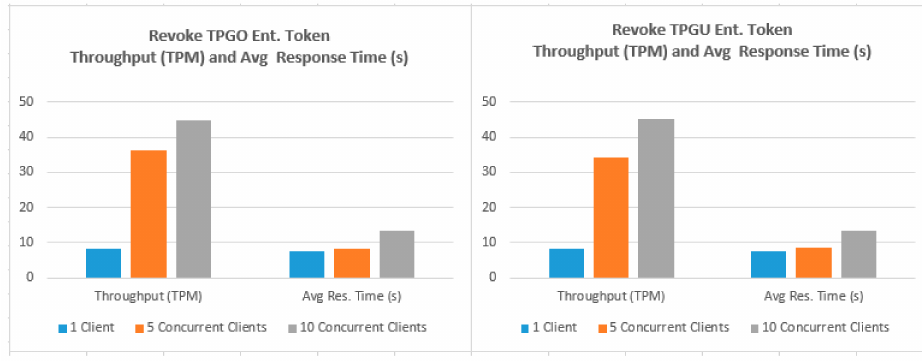
Figure 21. Throughput (TPM) vs. Average Response Time (s) for Revoke Token